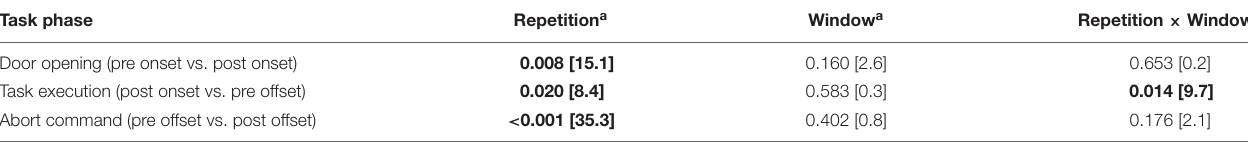
TABLE 6 | Effects on the pupil diameter of performing repeated tasks. Task phase Repetition a Window a Repetition × Window